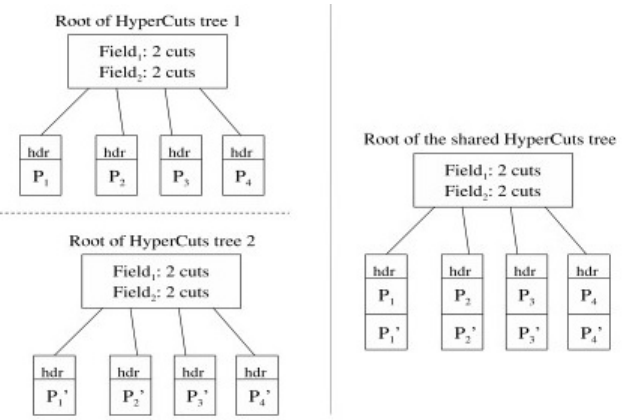
Figure 3. Example of Shared HyperCuts tree: ( Left ) Two separate HyperCuts trees. ( Right ) The corresponding shared HyperCuts